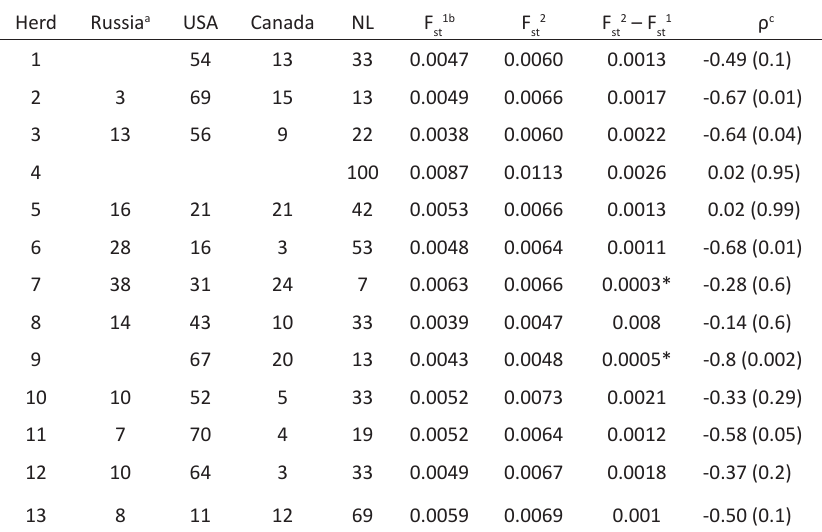
Table 2. Mean of F values between a particular herd and other herds using either Sample 1 (F st or Sample 2 (F